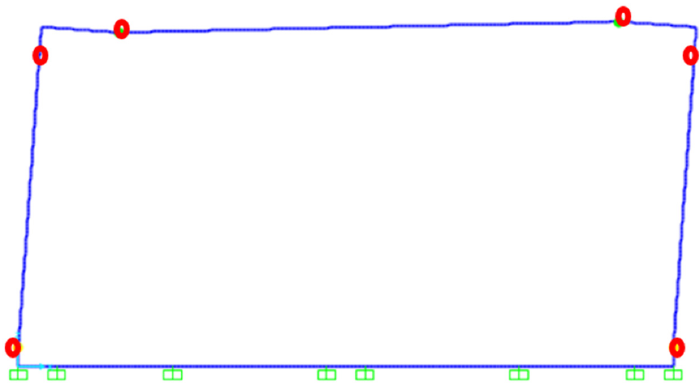
Figure 17. Numerical simulation of the surrounding RC frame with the location of the plastic hinges.